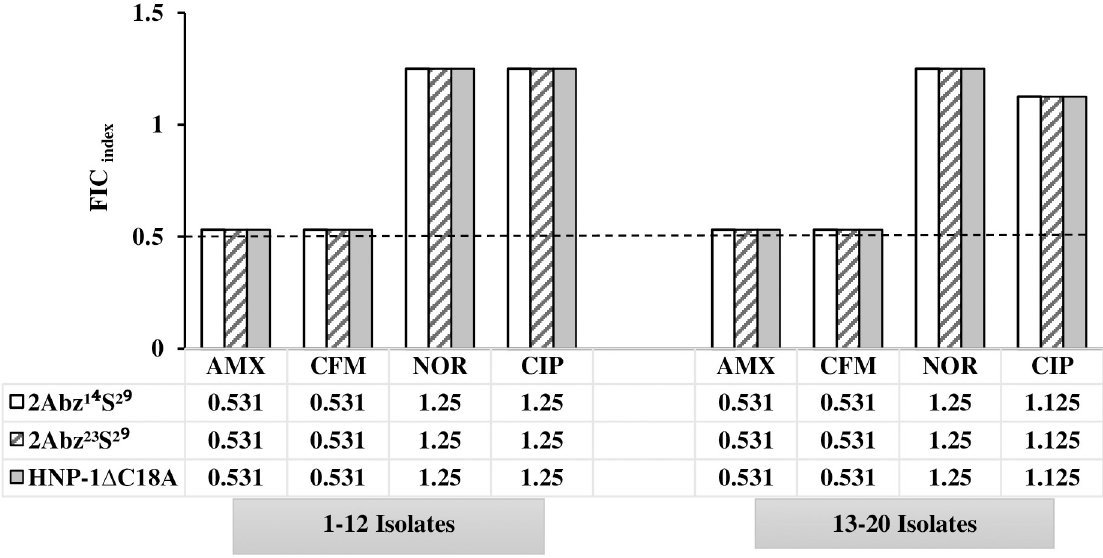
Fig 2. Fractional Inhibitory Concentrations (FICs) indices of combinations consisting of antibiotics and either of three antimicrobial peptides against MDR clinical E . coli isolates (n = 20). Black dashed line denotes the cutoff FIC index of � 0.5 for synergistic interaction. FIC index � 0.5, synergistic; 1 > FIC index > 0.5, additive; 1 < FIC index > 4.0, indifference, FIC index > 4.0 antagonistic. See Supplementary Material (S1 and S2 Tables) for MIC and FIC values.